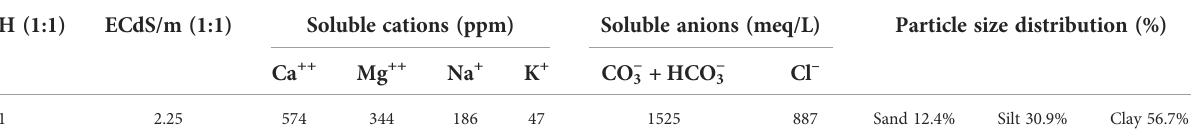
TABLE 1 Physical and chemical characteristics of the used